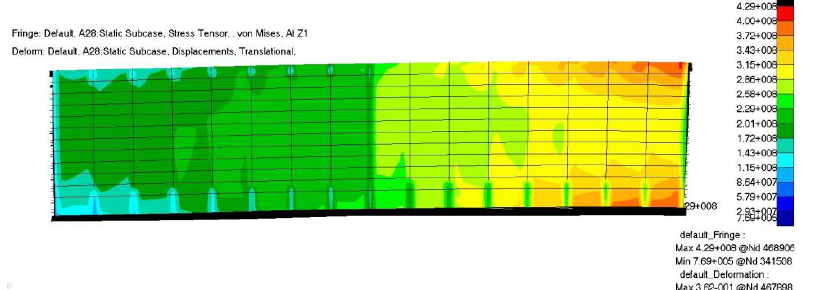
Figure 24. Stress cloud map of cabins 4 and 5 at high tide level on the day of the incident.